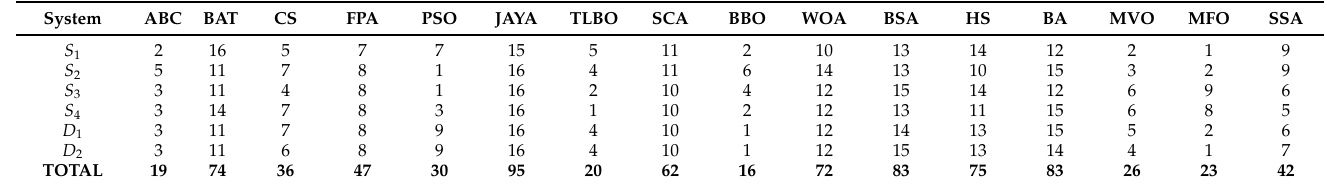
Table 13. Success ranking according to the best results of the metaheuristic algorithms for the test process.